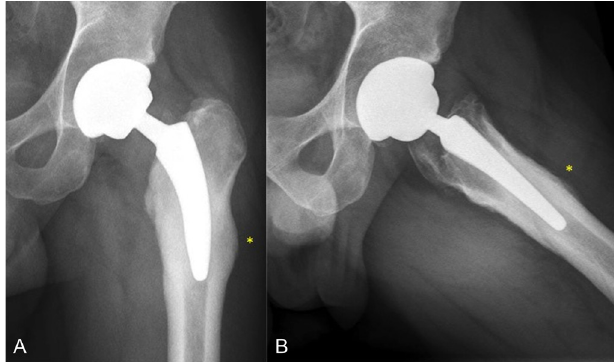
Figure 5. A and B. Left hip ’ s anteroposterior and lateral radiographs at 2 and half years of follow-up, evidencing a hypertrophic callus (*) with no signs of stem loosening, being the patient completely